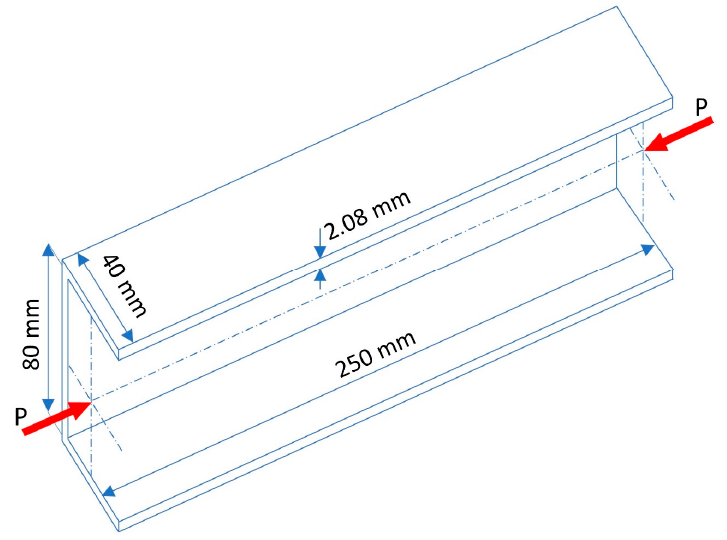
Figure 1. Dimension of the glass fiber-reinforced polymer (GFRP) strut.